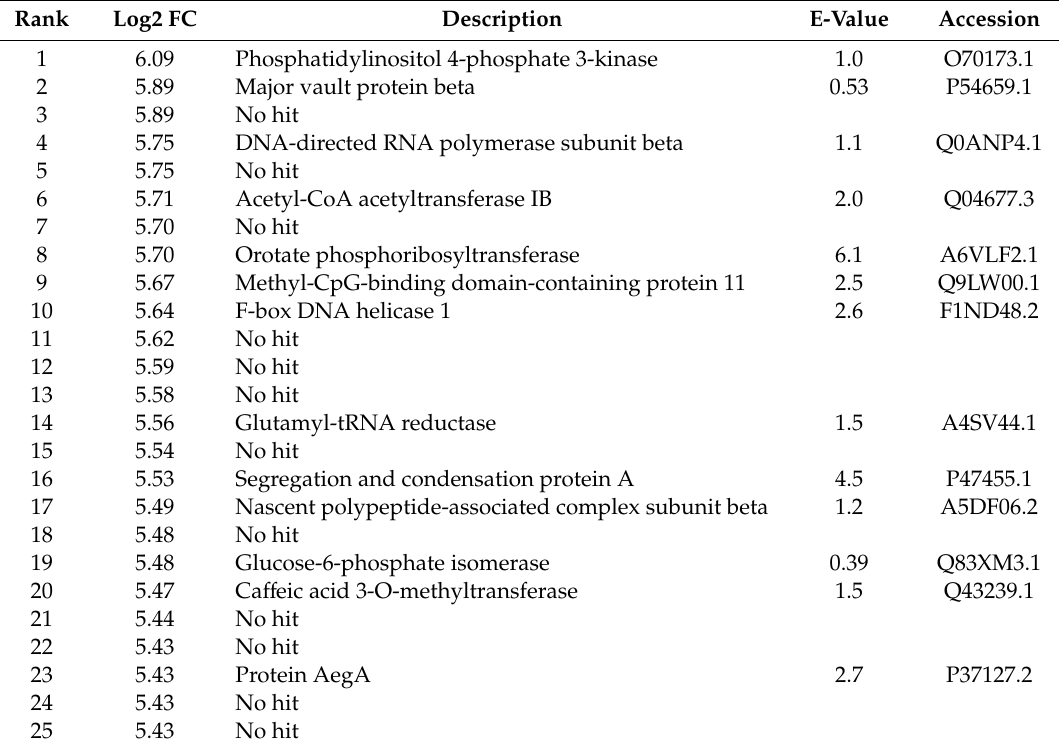
Table A4. Top 25 up-regulated transcripts of Inonotus obliquus library of cells cultivated in presence of white birch bark.